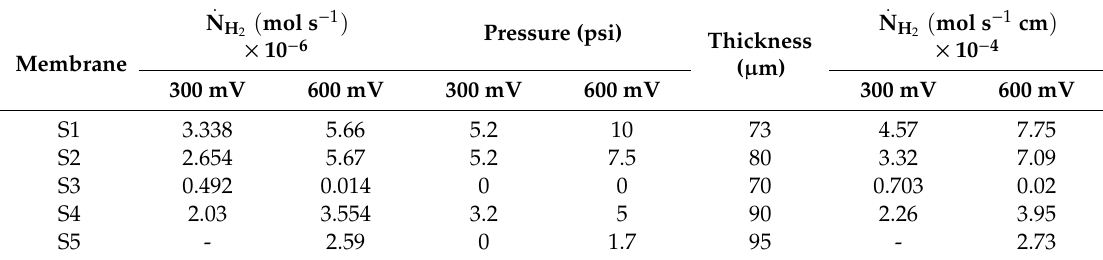
Table 5. Hydrogen transferred according to applied potential